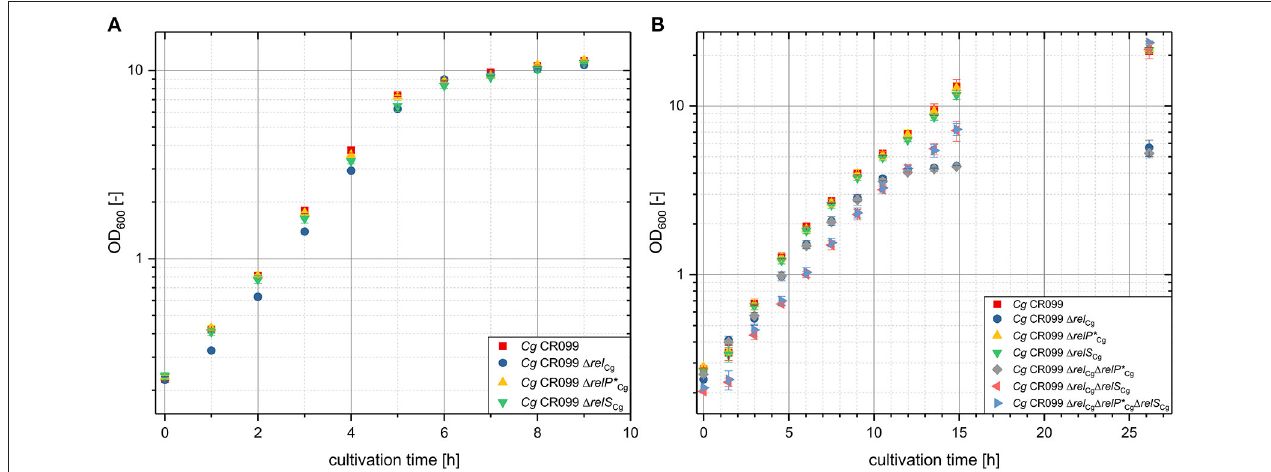
FIGURE 2 | Effect of the deletion of genes with a putative (p)ppGpp synthetase motive on the growth of C. glutamicum CR099 in complex CASO-broth (A) and minimal CGXII medium (B) . To preclude possible enrichment of suppressor mutants all cultures were inoculated from precultures in complex CASO-broth. An initial OD 600 of 0.2 was used for the cultivation in CASO-broth. For the growth analysis in CGXII minimal medium, the precultures were washed in the main culture medium and then diluted to an OD 600 of 0.5. Mean values and standard deviations shown were calculated from three biological